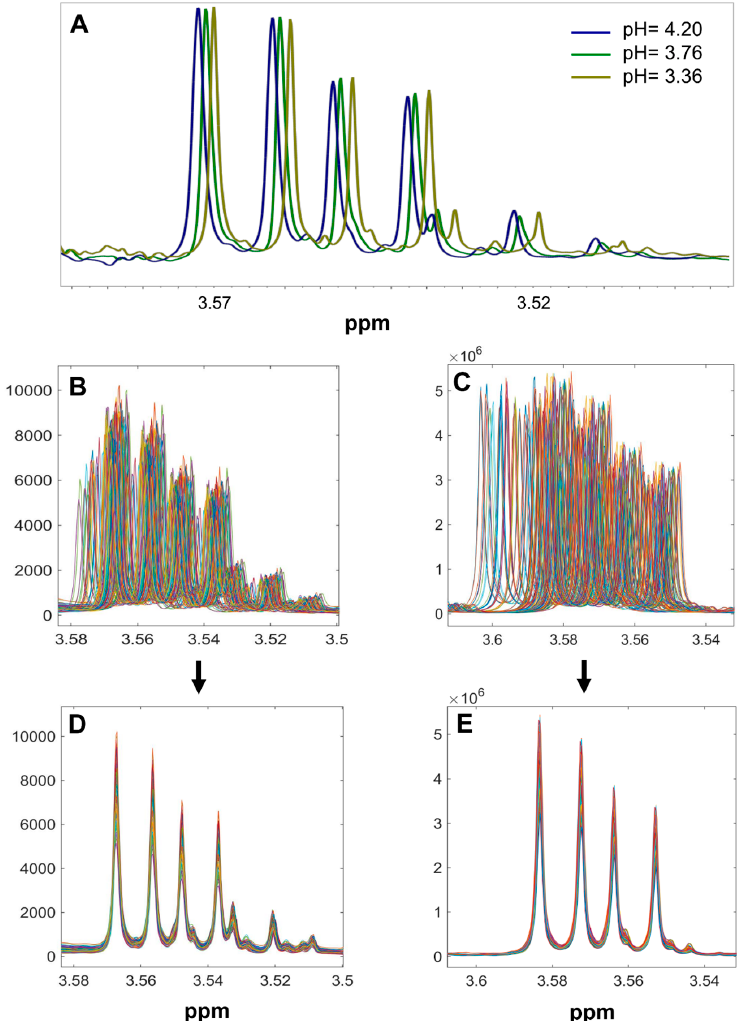
Figure 7. Expansion of the glycerol signal in the 1 H-NMR spectra of the wine samples at 3 different pH values ( A ); expansion of the glycerol signal in wet wines ( B – D ) and dried wines ( C – E ) before and after alignment, respectively.